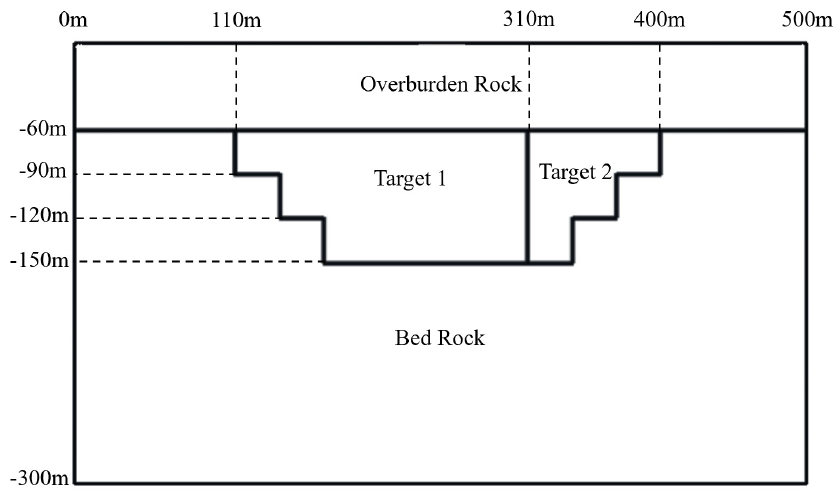
Figure 13. Schematic diagram of model 2.